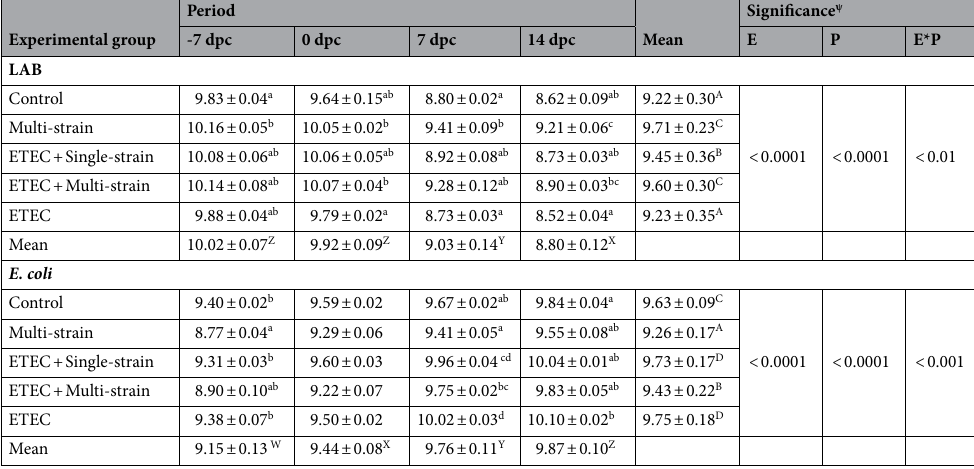
Table 1. Faecal LAB and E. coli counts (log(CFU/g)) in pigs in each experimental group throughout the experiment. abc Means with different superscript differ significantly. ABCD/WXYZ Means with different superscript within a column (ABCD) or row (WXYZ) differ significantly. ψ Significant effects of experimental group (E), period (P) or their interaction